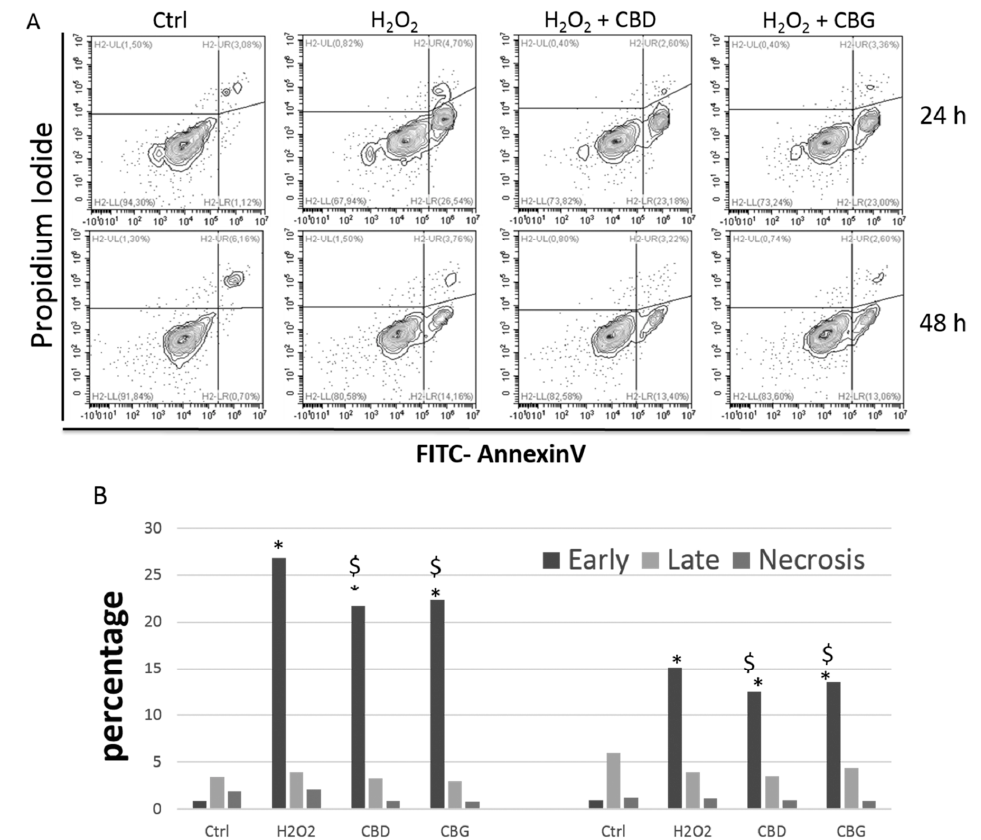
Figure 3. Apoptosis occurrence in CTX-TNA2 astrocyte cell line exposed to 1000 nM CBD and 1 nM CBG and challenged with H 2 O 2 for 24 and 48 h. ANOVA, * p < 0.05 vs. control group; $ p < 0.05